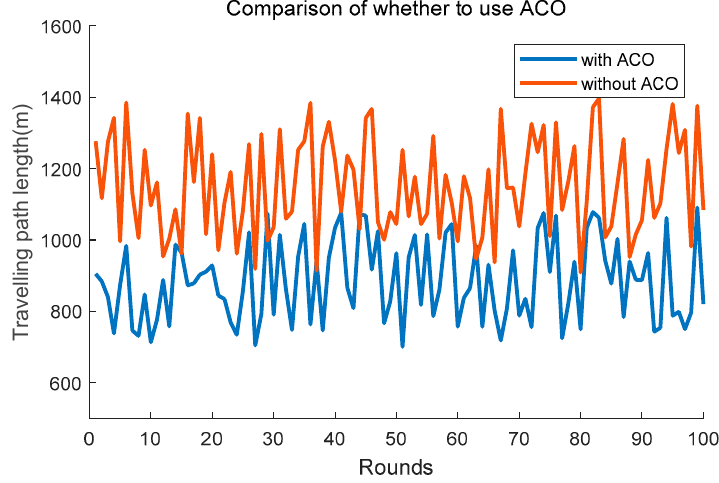
Figure 12. Comparison of whether to adopt ACO.